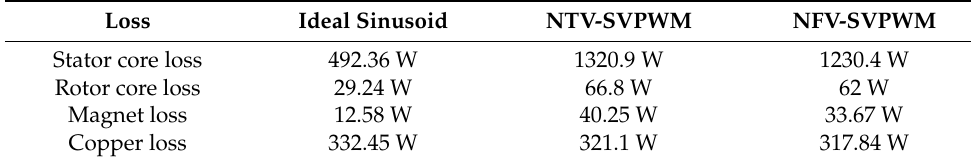
Figure 21. Motor torque under different modulation algorithms ( a ) ideal sinusoidal, ( b ) NTV-SVPWM, and ( c ) NFV-SVPWM. Table 4. Motor loss under different modulation algorithms.